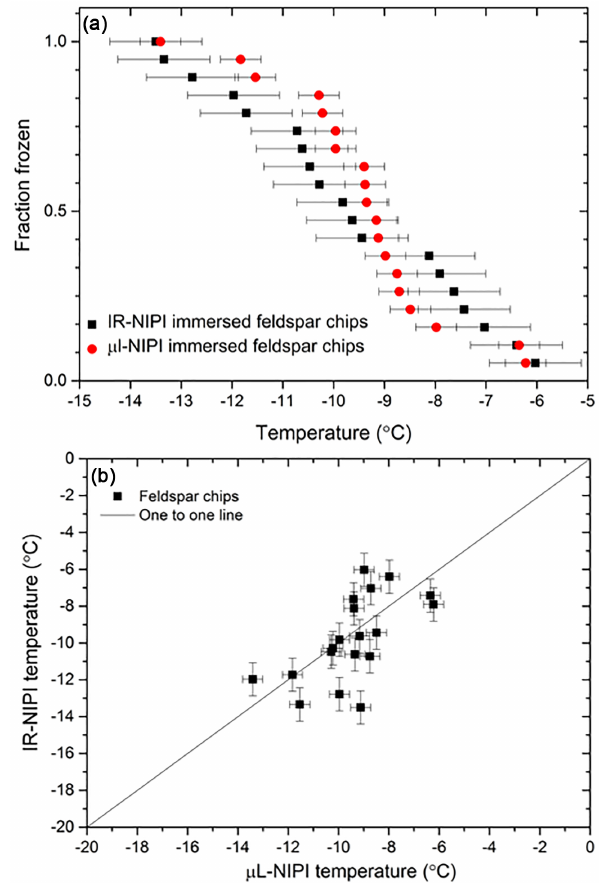
Figure 7. Active site densities, n s (T ) , for NX-illite. (a) The active site density for a dilution series of NX-illite run on the IR-NIPI in- strument for a range of concentrations. The data for a repeat experi- ment are also shown. The error bars represent the temperature error of ± 0 . 9 ◦ C. (b) The active site density for NX-illite from this study compared to literature data. Data from wet-dispersed techniques are displayed in black, with the IR-NIPI highlighted in red and Auto- mated Ice Spectrometer (AIS) in green. Data from dry-dispersed techniques are also plotted as hollow blue